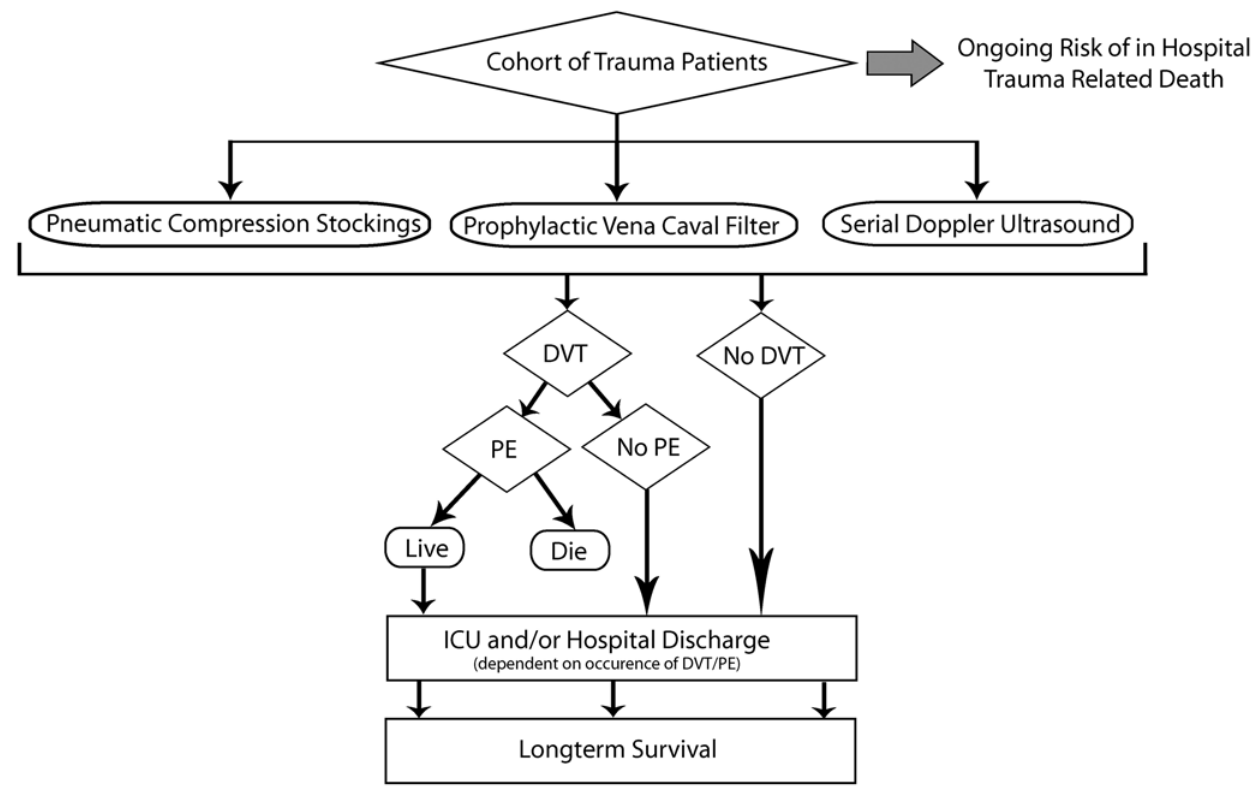
Figure 1. Model of three venous thromboembolism prophylaxis strategies.